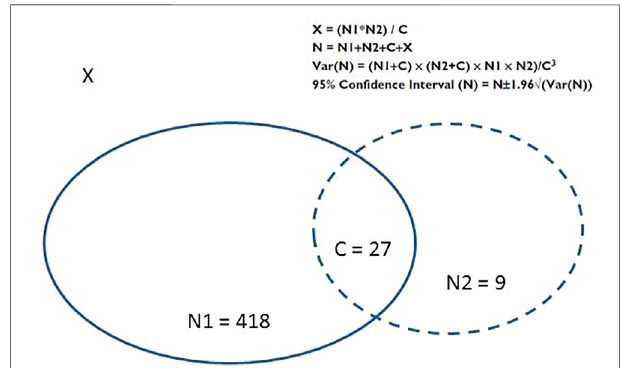
FIGURE 1 | Distribution of cases in the two data sources, and the statistics of the capture-recapture method (Lugardon et al., 2006). C: the number of cases shared by the two sources; N, the total number of cases; N1+ C, the number of AKIs reported by the fi rst information source (i.e., the “ capture ” ); N2 + C: the number of AKIs reported by the second informationsource (i.e., “ recapture ” );Source 1:capture (thecohortofpatients withdrug-inducedAKI);Source2,recapture(the FPVD);Var(N),varianceofN; X, the number of unidenti fi ed